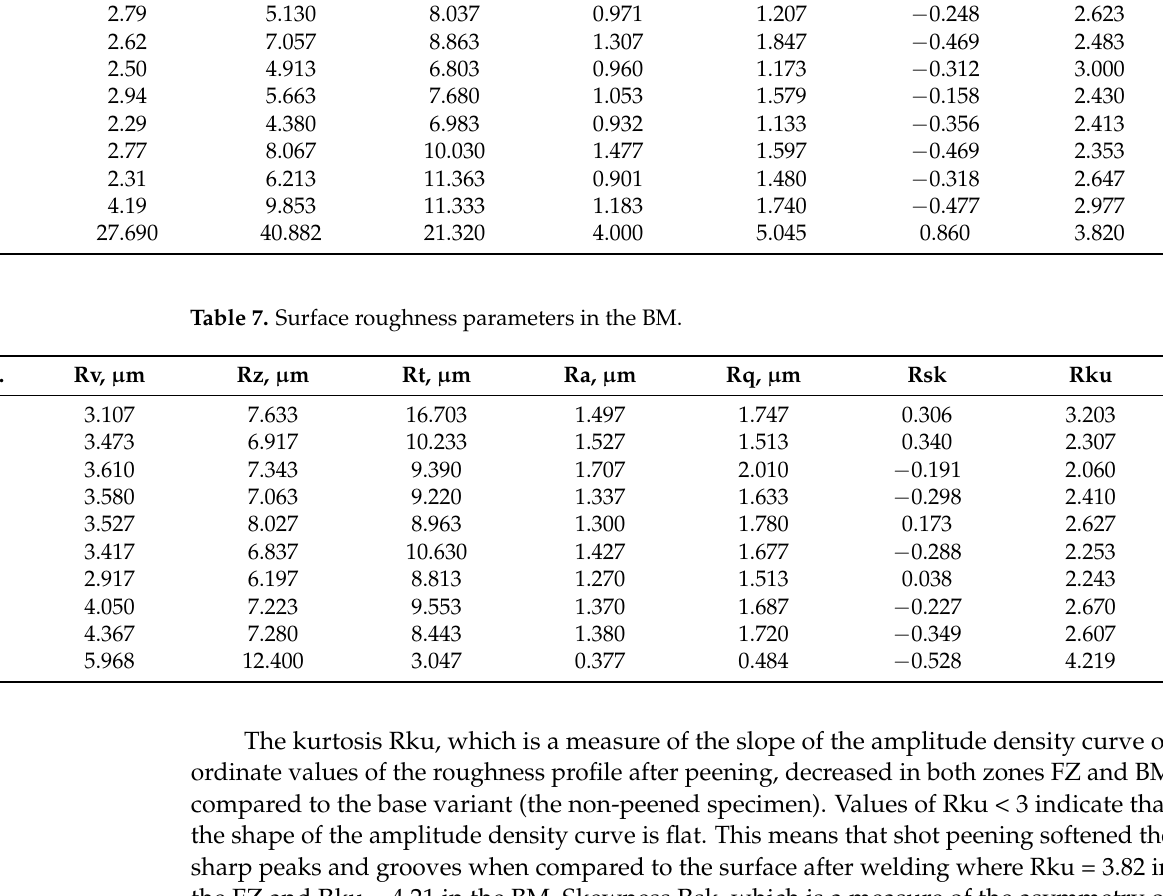
Figure 5. Three-dimensional roughness topography for variant 1 (specimen after shoot peening using the following parameters: t = 4 min, p = 0.6 MPa) in the ( a ) FZ and ( b ) BM. Table 6. Surface roughness parameters in the FZ. Variant No.